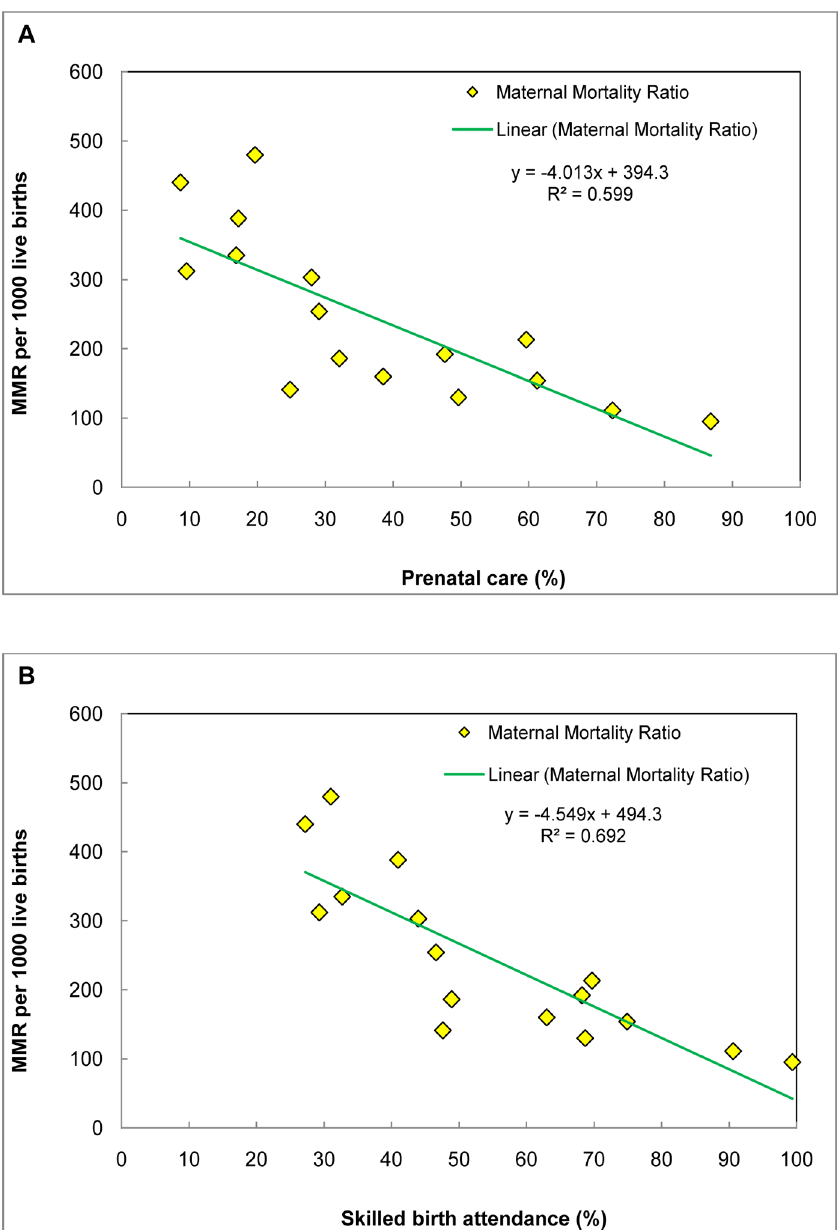
Figure 1. Association between maternal health care (prenatal care and skilled birth attendance) and maternal mortality ratio across 15 major states, India. A . X axis=Prenatal care (%). Y axis=Maternal mortality ratio (MMR) per 1000 live births. B . X axis=Skilled birth attendance (%). Y axis=Maternal mortality ratio (MMR) per 1000 live births.